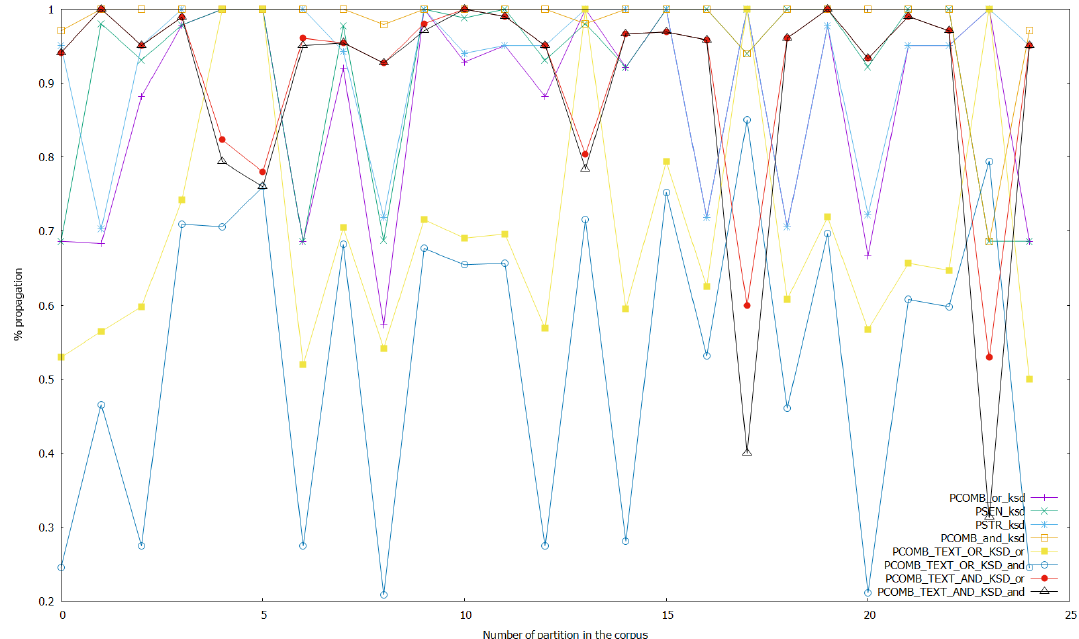
Figure 5. Results of the experiments with the sentiment, stress, and combined analyses on keystroke data, and with the combined analyses on text and keystroke data with thresholds